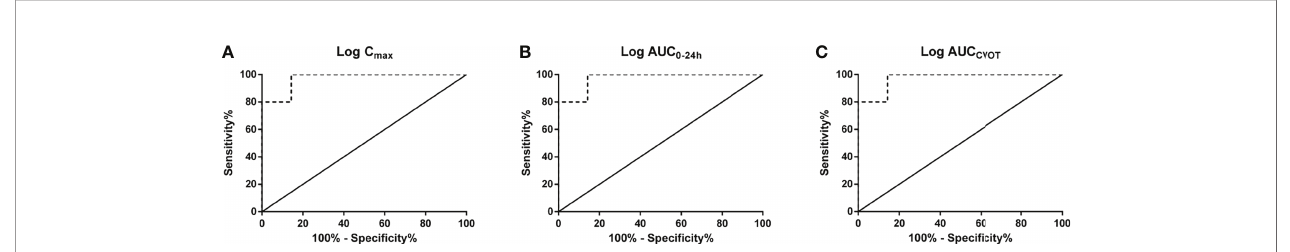
FIGURE 2 | Receiver operating characteristic (ROC) curves. (A) log C max ; (B) log AUC 0 – 24h ; (C) log AUC CVOT